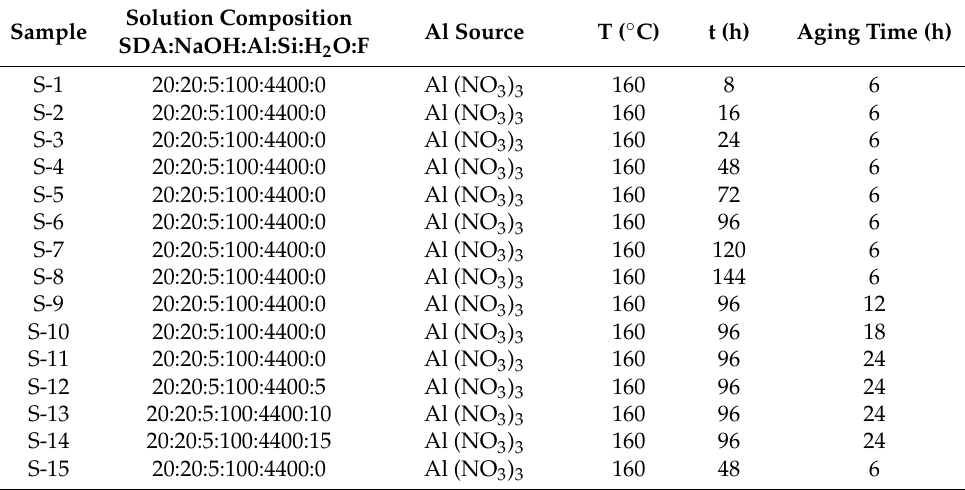
Table 1. Synthesis conditions of SSZ-13 molecular sieves.